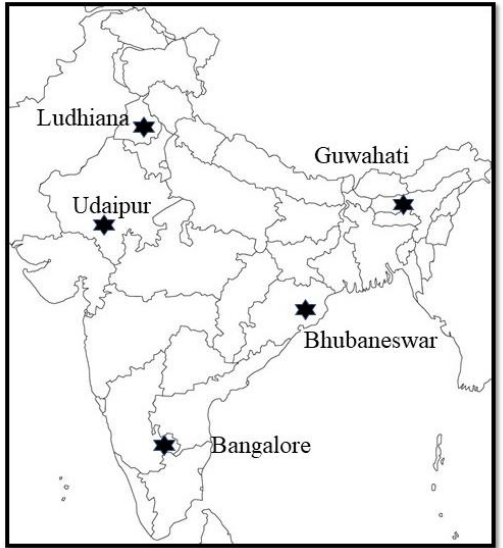
Figure 1. Location of selected cities in India.